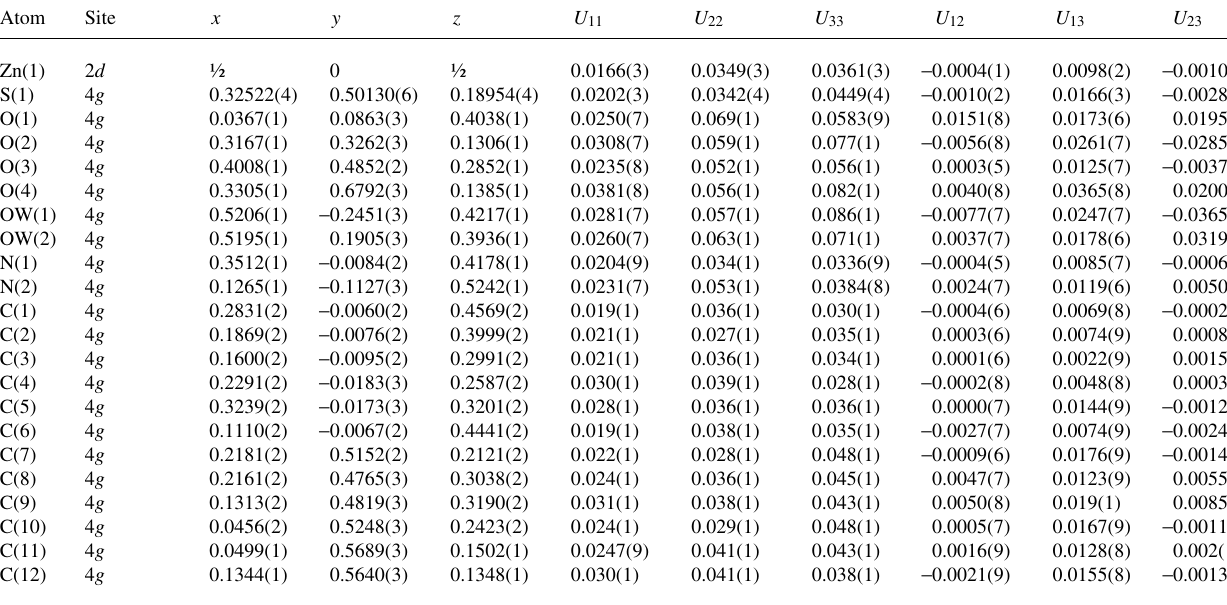
Table 3. Atomic coordinates and displacement parameters (in Å 2 )